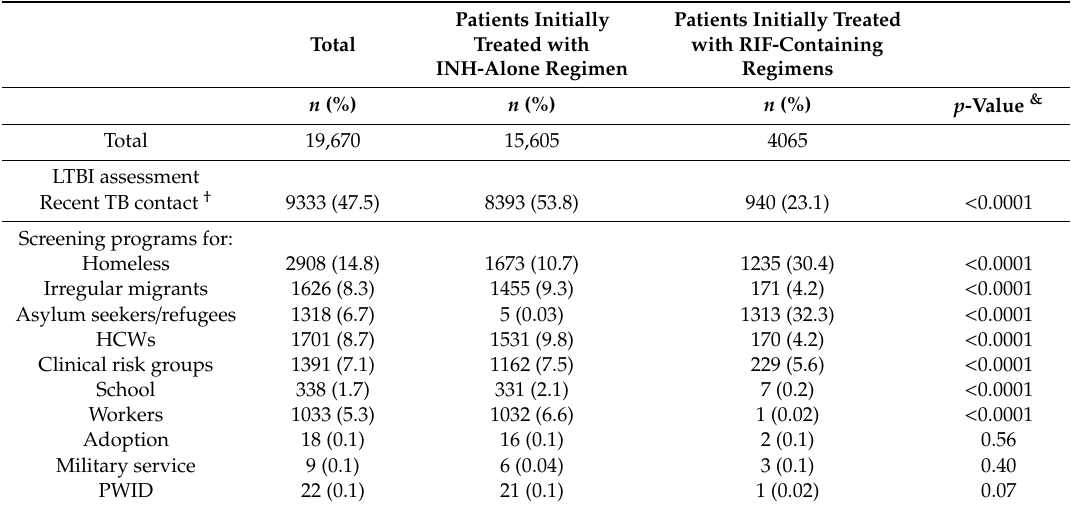
Table 2. Reasons behind the assessment of LTBI treated in groups treated with INH-alone or RIF-containing regimens ( n =